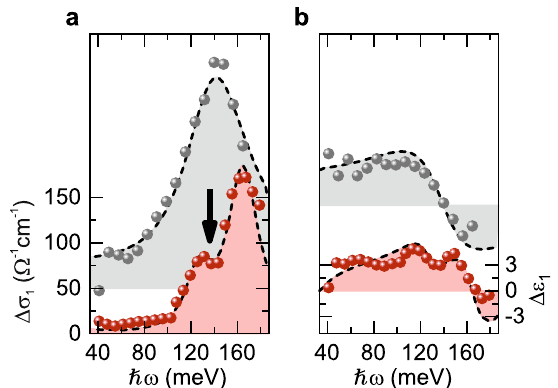
Fig. 2 Pump-induced dielectric response of WSe 2 /hBN and WSe 2 / gypsum heterostructures. a , b Pump-induced changes of the real part of the optical conductivity Δ σ 1 ( a ) and the dielectric function Δ ε 1 ( b ) as a function of the probe photon energy for different heterostructures at t pp = 0 ps following resonant femtosecond photogeneration of 1 s A excitons. Gray spheres: photoinduced dielectric response of a WSe 2 ML/hBN heterostructure. Red spheres: photoinduced dielectric response of a WSe 2 ML/gypsum heterostructure. The data are vertically offset for clarity. The dashed lines are fi ts to the experimental data based on the theoretical model in Eq. (1), by setting V 1 and V 2 to zero. The arrows indicate the characteristic dip in Δ σ 1 arising from the strong exciton – phonon